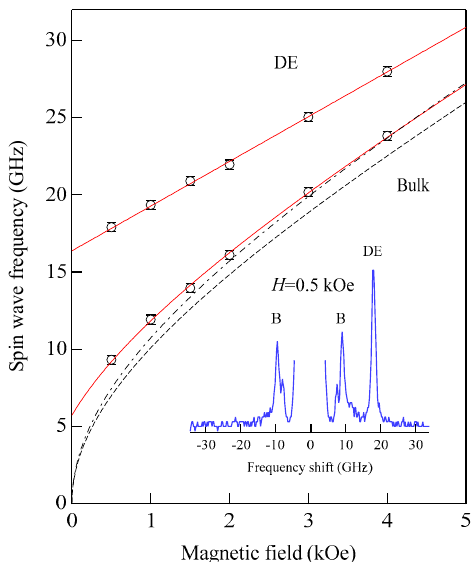
Figure 5. SW frequencies of Fe 64 Al 19 O 17 film as a function of the magnetic field. A BLS spectrum at H = 0.5 kOe is also shown. The solid lines are the calculated SW frequencies using Equation (33) with g = 2.07, 4 π M B = 11.1 kG, 4 π M DE = 11.3 kG, and H ex = 0.34 kOe. The broken line (4 π M B = 11.1 kG) and dots and dashes (4 π M B = 12.7 kG) are the calculated frequencies without the H ex term [54].